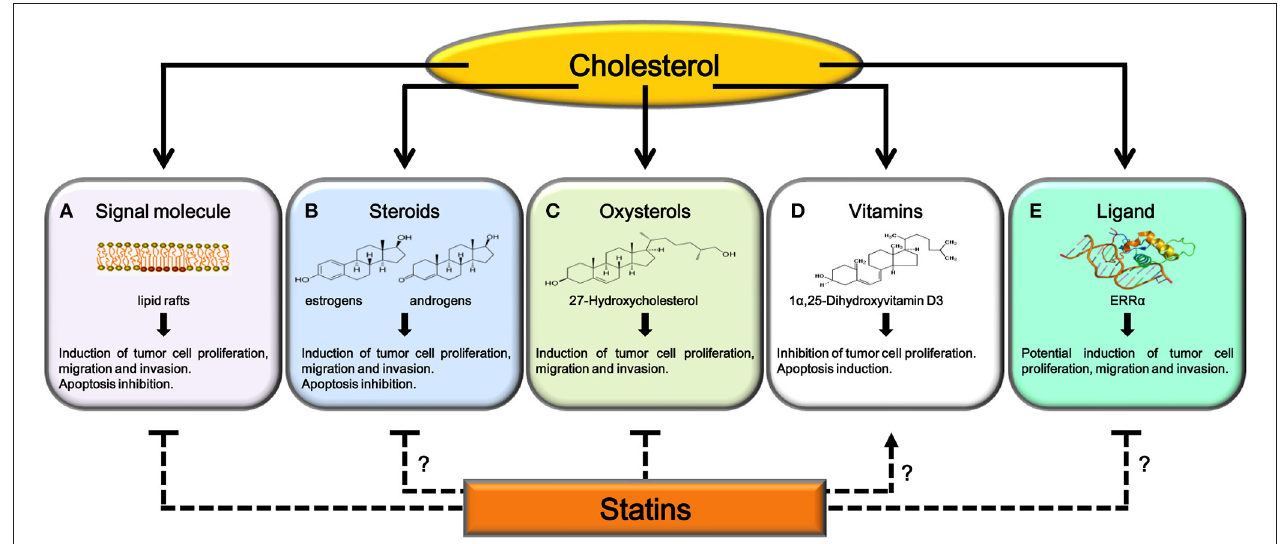
FIGURE 1 | Potential mechanisms explaining antitumoral effects of statins. Cholesterol, after its utilization as signaling molecule (A) , as substrate for steroids (B) , oxysterols (C) , and 1 α ,25(OH)2D3 synthesis (D) or as ligand for ERR α (E) , regulates tumor growth and progression. Statins, inhibiting cholesterol synthesis, interfere with (A) and (C) . Further studies are needed to confirm statins ability to: reduce production of steroid hormones involved in cancer progression (B) , increase serum or intratumor 1 α ,25(OH)2D3 levels (D) or interfere with ERR α activity (E) .